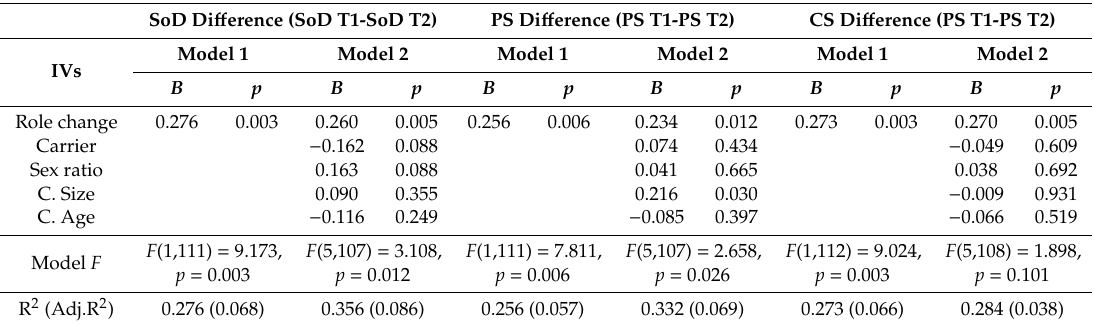
Table 6. Hierarchical regression for predicting SoD, PS, and CS di ff erences, including class variables (Group 1: Bully group).